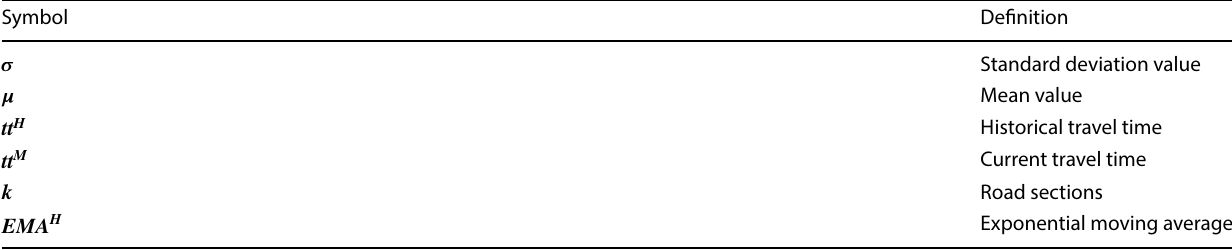
Table 1 Key mathematical symbols and abbreviation